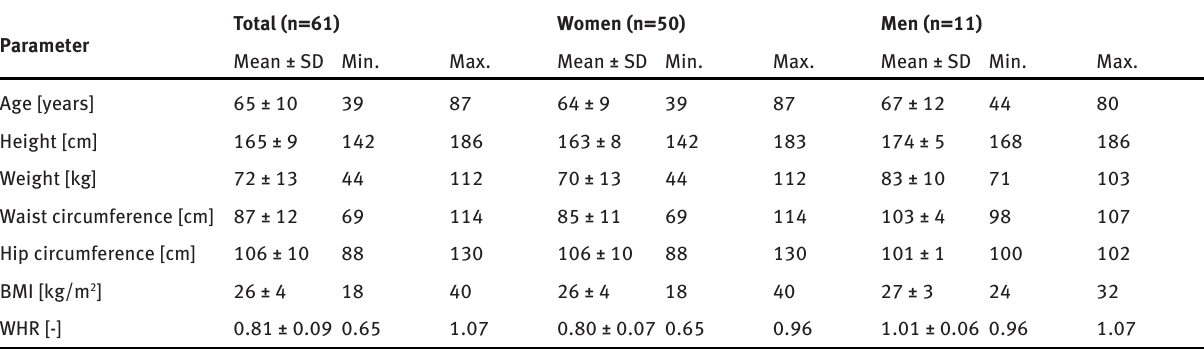
Table 1: Basic characteristic of the students